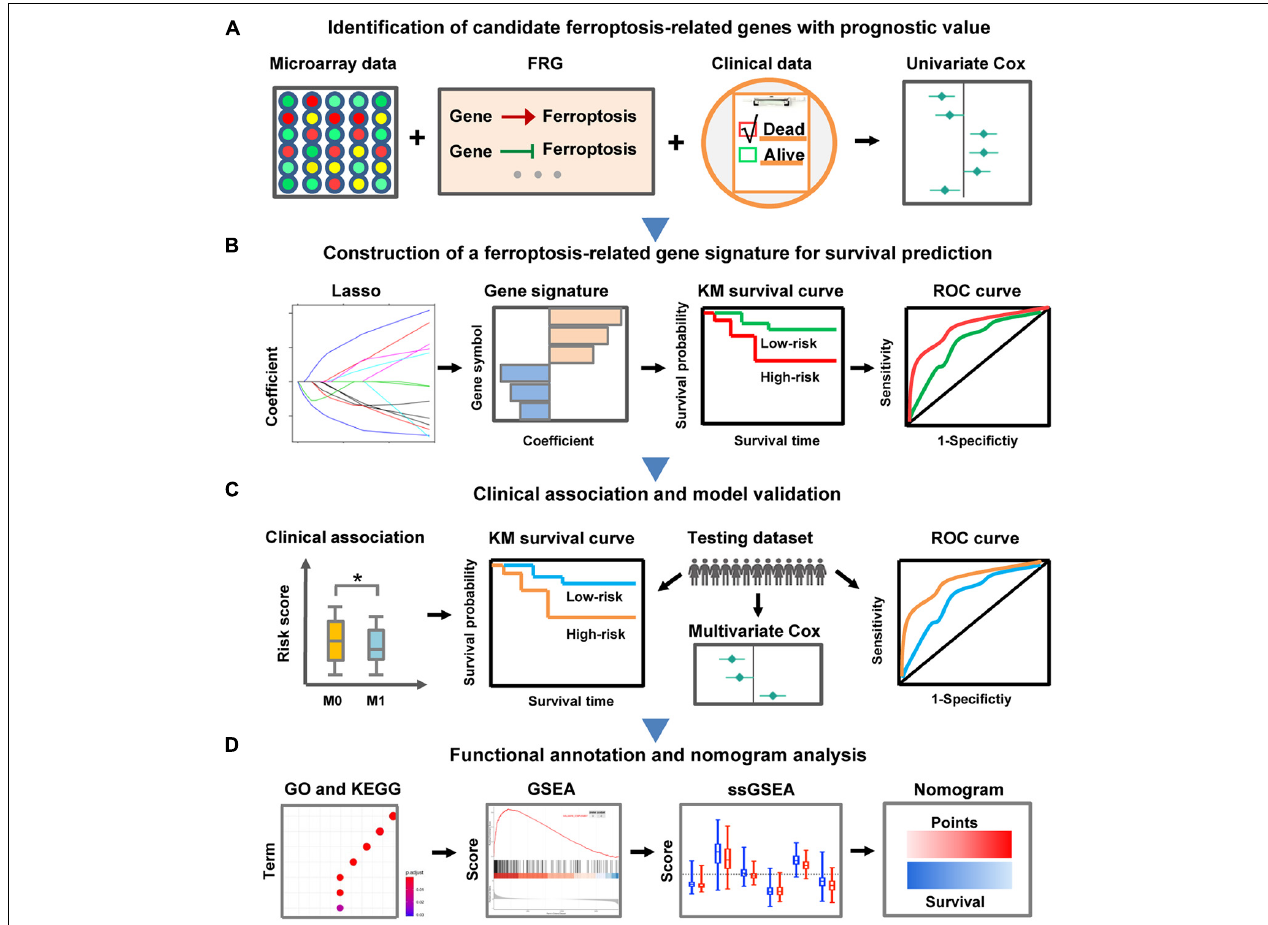
FIGURE 1 | Schematic diagram of the FRG-related prognostic signature construction and characterization. (A) The FRGs with prognostic value were identified in CC through differential expression analysis and univariate Cox regression analysis. (B) LASSO Cox regression analysis was employed to develop a robust FRG signature for prognosis. (C) Clinical relevance exploration and independent validation of the FRG signature. The symbol ∗ means statistically significant. (D) Functional annotation of the FRG signature and construction of a nomogram predicting overall